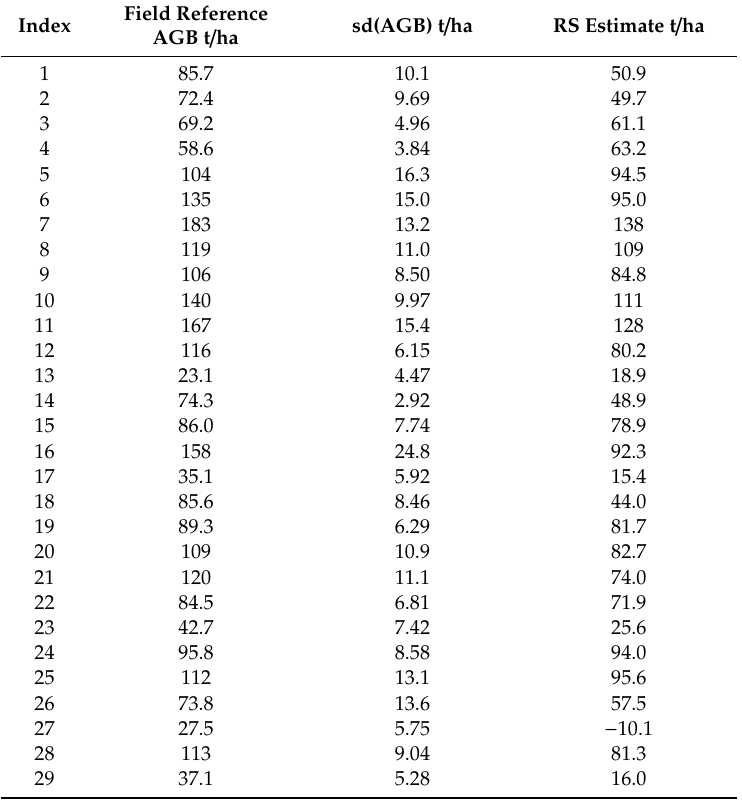
Table A2. Table with stand values for the dataset Krycklan used in the case study. Field estimated ( ˆ T Ref ) biomass (AGB), standard deviation of biomass (sd), and the estimates based on RS data ( ˆ T RS ). The standard deviation was computed as the standard deviations of the sample plots for each